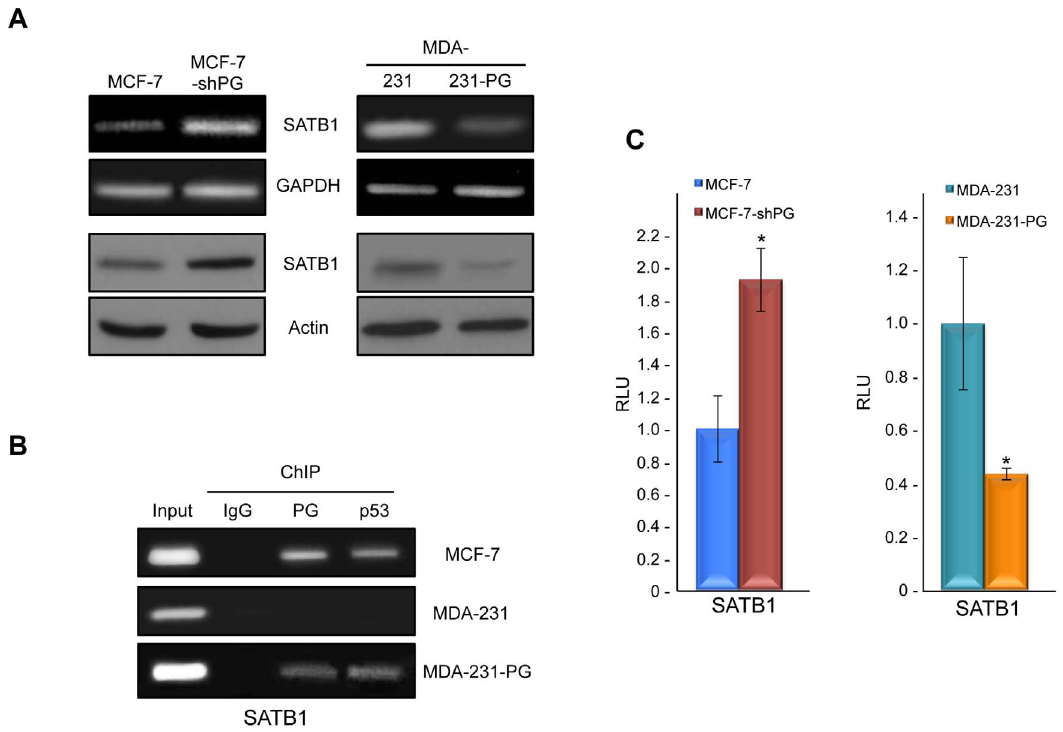
Figure 2. Plakoglobin suppresses SATB1 in mammary epithelial cell lines. A. (Top) Total cellular RNA was isolated from MCF-7, MCF-7-shPG, MDA-231 and MDA-231-PG cells, reverse transcribed and processed for PCR using primers specific to SATB1 and GAPDH. (Bottom) Equal amounts of total cellular proteins from these cells were resolved by SDS-PAGE and processed for immunoblotting with antibodies to SATB1 and Actin. B. MCF-7, MDA-231 and MDA-231-PG cells were formaldehyde fixed and processed for chromatin immunoprecipitation as described in Fig. 1B. The purified DNA was then processed for PCR using SATB1 primers. As a positive control, total cellular DNA (Input) was amplified using the same primers. C. MCF- 7, MCF-7-shPG, MDA-231 and MDA-231-PG cells were transfected with luciferase reporter constructs and processed as described in Fig. 1C. The SATB1 promoter activity was normalized to the corresponding vector activity for each cell line and then normalized to MDA-231 or MCF-7, respectively (*p , 0.01). PG, plakoglobin; RLU, Relative Light